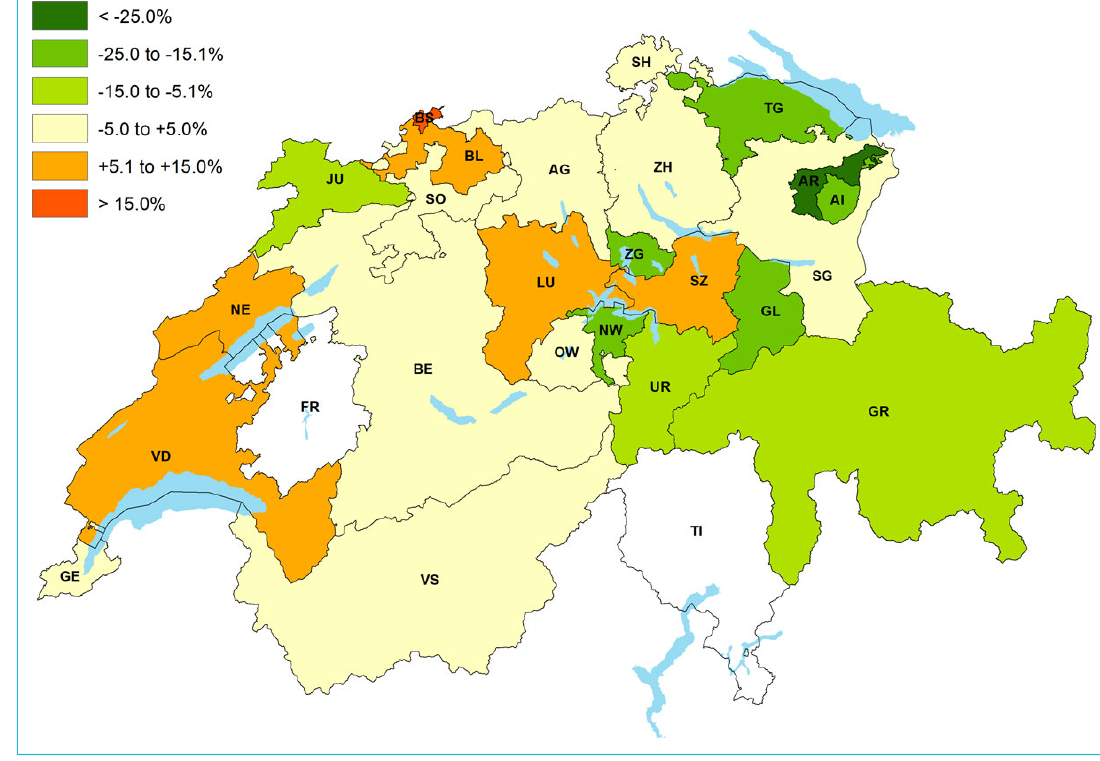
Table 2: Prevalence of polypharmacy and number of different concurrent drugs per person in NHR and the RG (individuals aged ≥65 years insured with Helsana, excluding NHR), 2nd quarter of 2016. NHR RG Total (n =